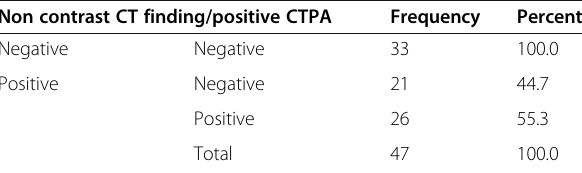
Table 2 Non-contrast CT significance and accuracy percentage in comparison to gold standard CTPA-positive